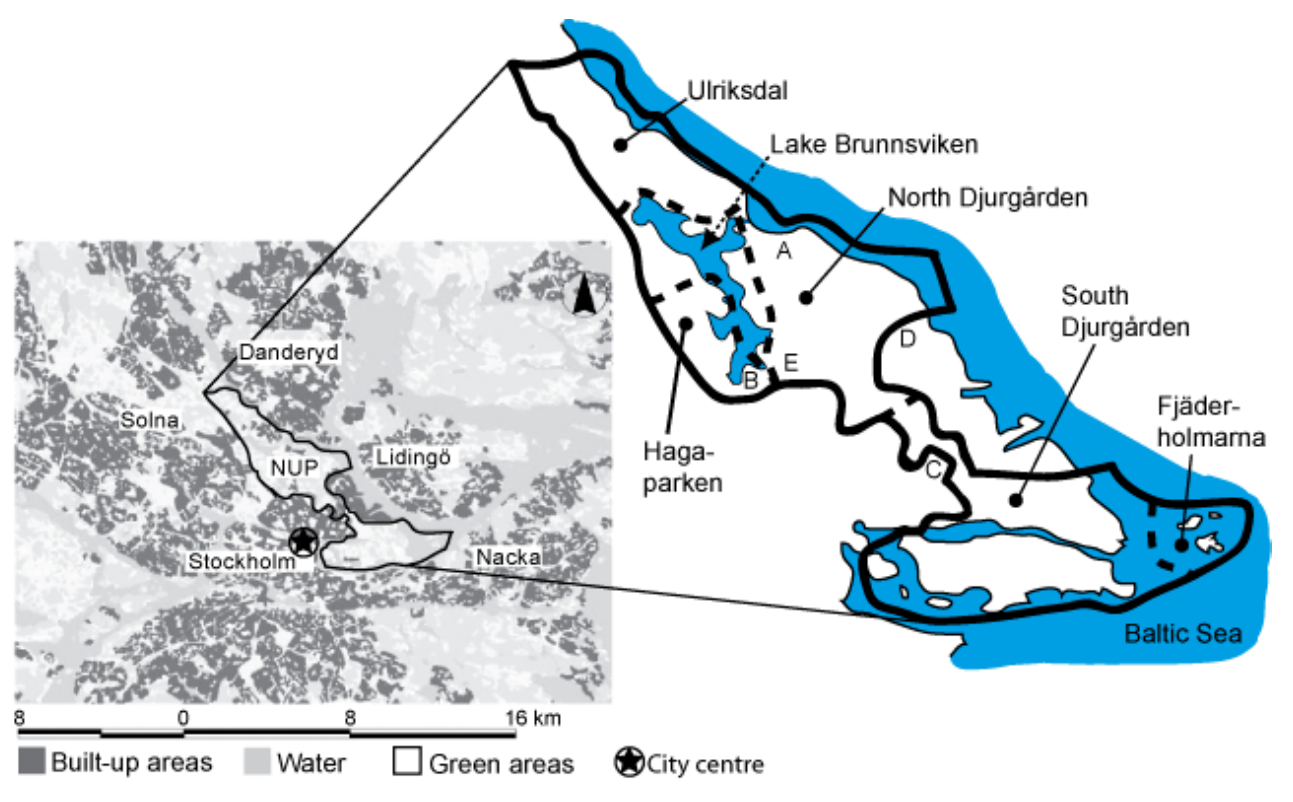
Fig. 2. The Stockholm National Urban Park (NUP; “Nationalstadsparken” in Swedish) lies close to the city center as shown in the map on the left. It stretches mainly into Stockholm and Solna municipalities, with a small part going into Lidingö. The map on the right shows the different historical areas of the park that were conceptually linked by the Ecopark movement (Ernstson and Sörlin 2008). Capital letters A–E mark sites for major planned development where the movement has been successful in stopping or altering the plans (see Table A2.1). For more information on the park’s ecosystems and management, see Barthel et al. (2005) and Borgström et al.